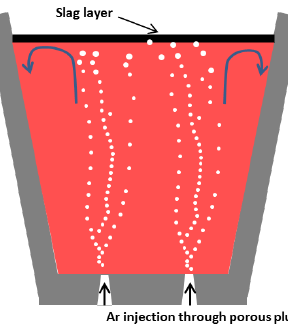
Figure 1. Schematic of a gas-stirred